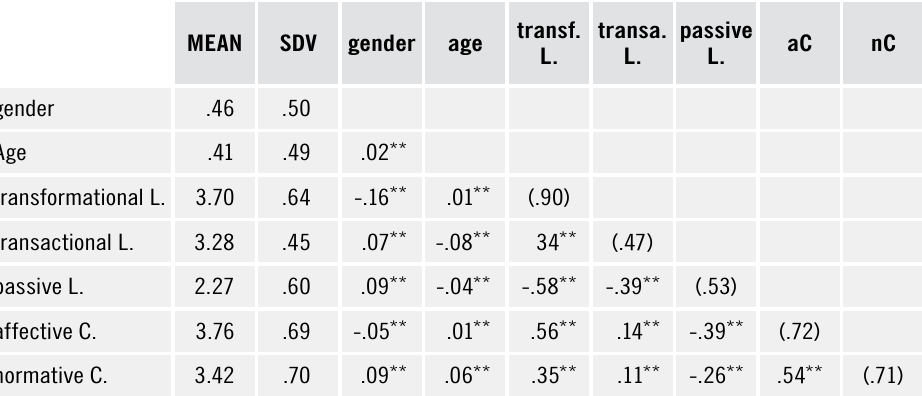
Table 1. Descriptive